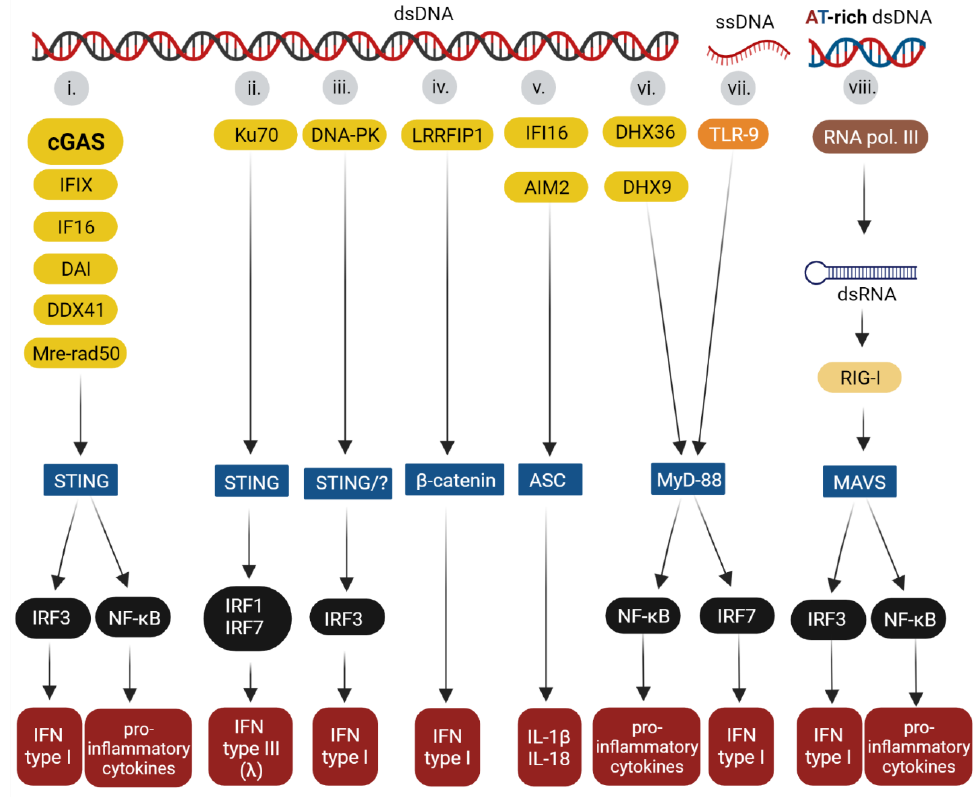
Figure 1. DNA sensors and their adaptor proteins involved in innate immune responses. The viral DNA that can be sensed by at least 14 pathways are: (i) dsDNA can be sensed by cGAS, IFI16, IFIX, ZBP1/DAI, DDX41, and MRE11-Rad 50 sensors that use the STING adaptor to induce the activation of IRF3 for IFN type I production and the activation of NF- κB for the production of pro-inflamma- tory cytokines; (ii) dsDNA sensing by Ku 70 protein activates IRF1 and IRF7 via STING for IFN- λ